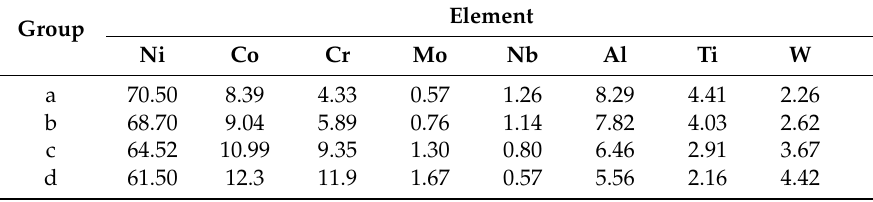
Table 2. Chemical compositions of γ and γ′ phases in K465 superalloy substrate by EPMA (mass